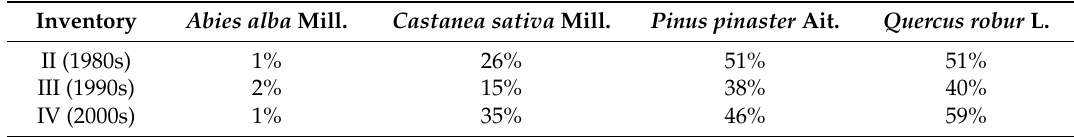
Table 1. Percentage of presences of the different species in Galicia during the three inventories. Inventory Abies alba Mill. Castanea sativa Mill. Pinus pinaster Ait. Quercus robur